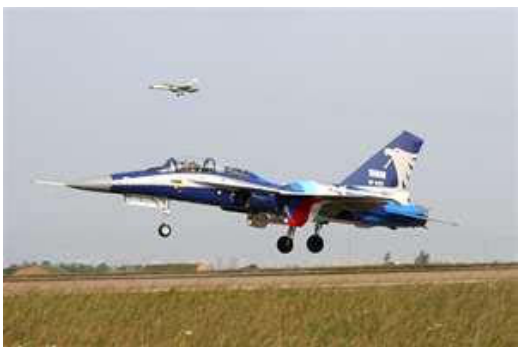
Figure 14. Original picture of an airplane.